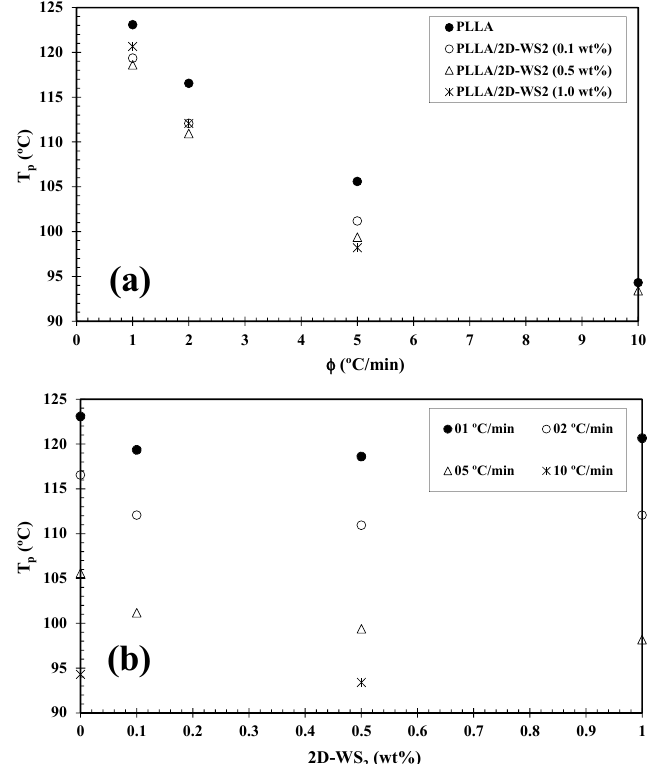
Figure 4. Variation of the crystallization peak temperature (T p ) for PLLA/2D-WS 2 nanocomposites with ( a ) cooling rate and ( b ) composition.